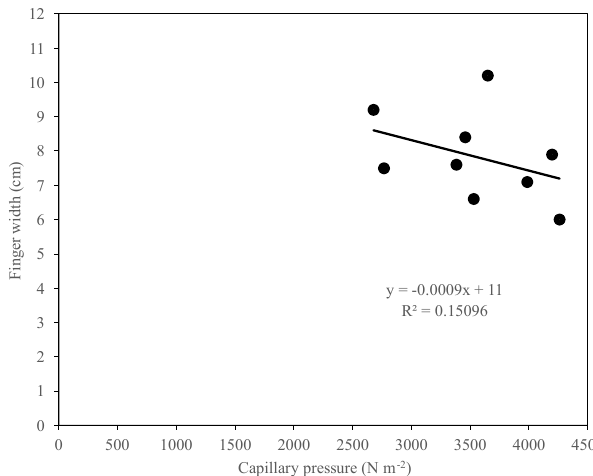
Figure 13. Finger width vs. capillary pressure of fully formed fin- gers resulting from infiltration of water in US Silica C778 ASTM graded sand for control (NaCl + HNS), plant exudates (citrate and oxalate), and soil components (tannic acid and organics: Suwanee River natural organic matter,